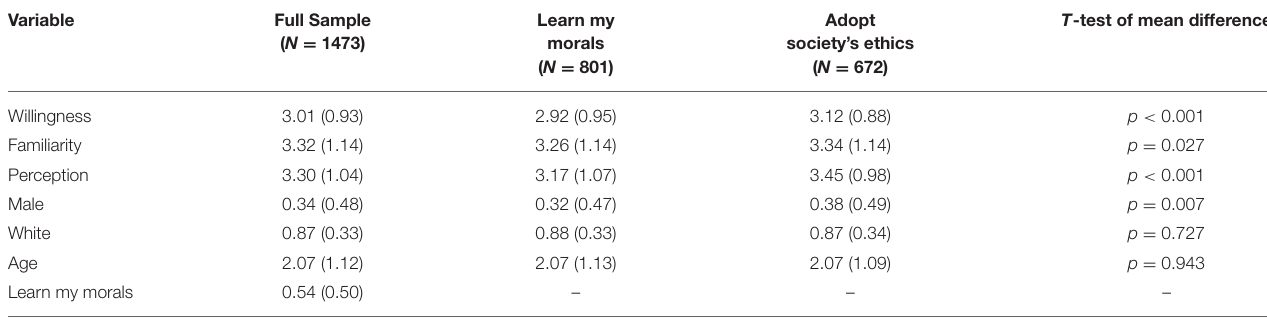
TABLE 2 | Full sample and subsample comparison.